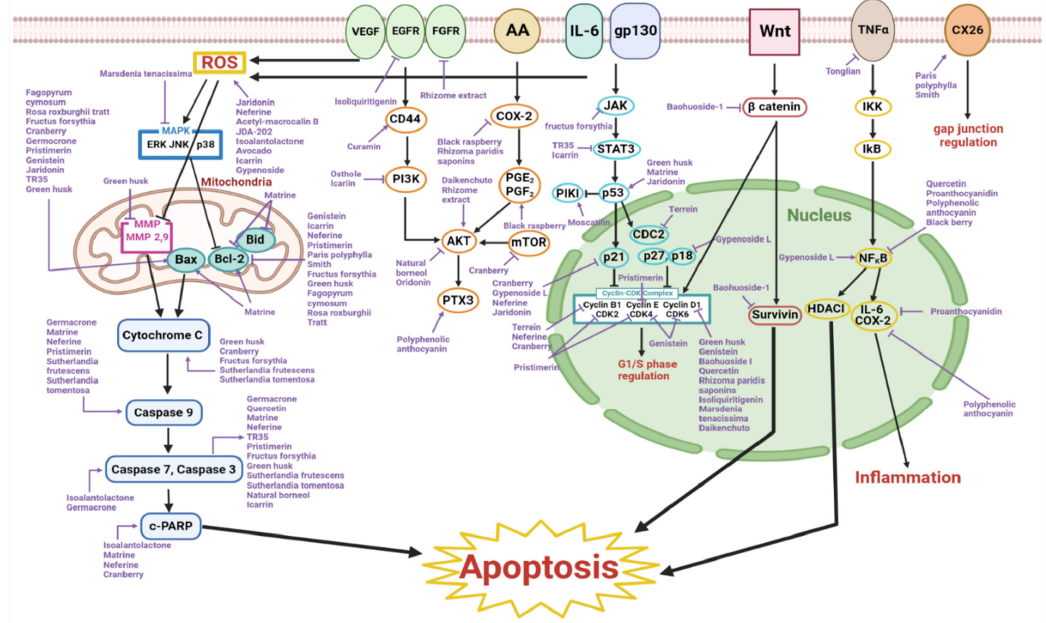
Figure 1. Schematic diagram of apoptosis ‐ inducing natural products in Esophageal Cancer.